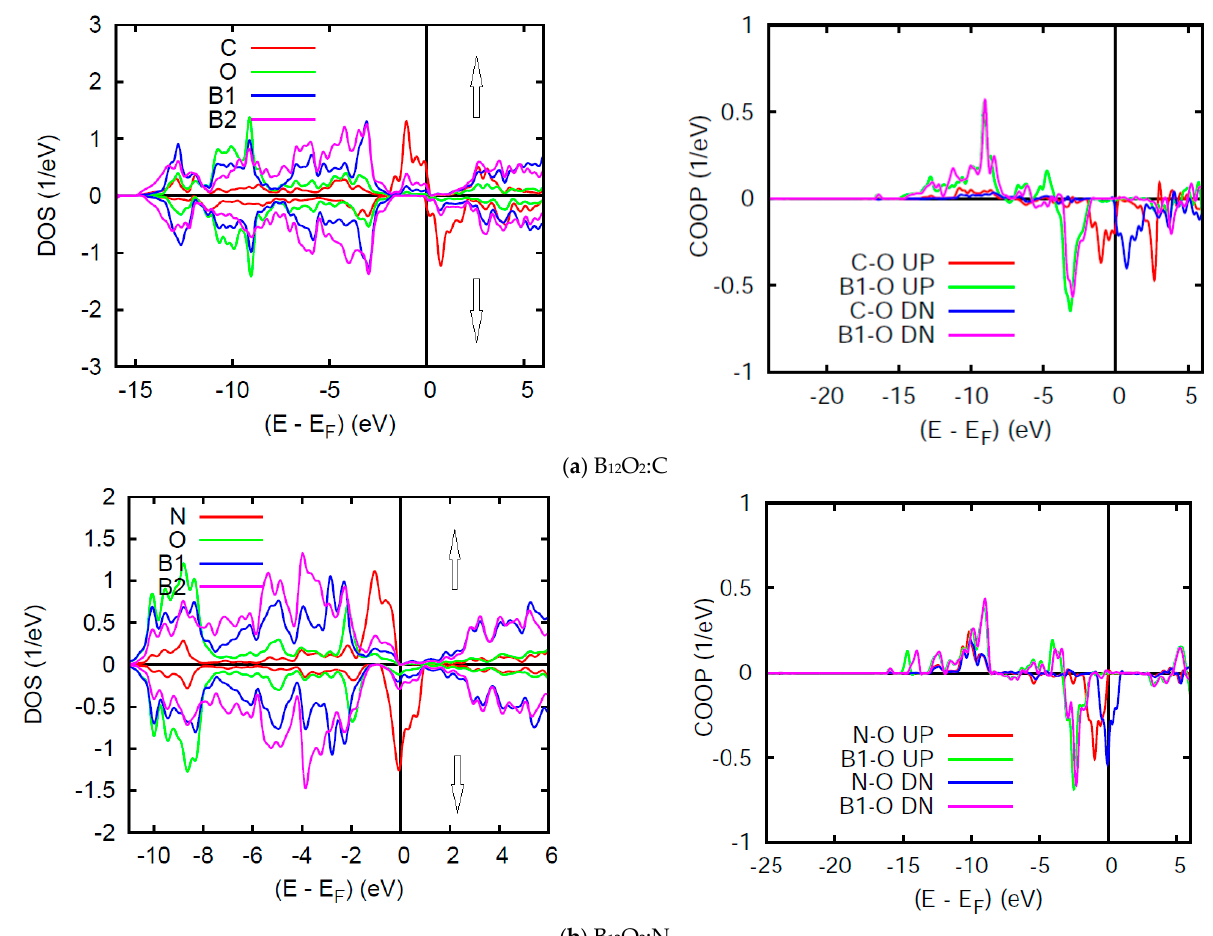
Figure 7. (color) . B 12 O 2 :X. Site and spin projected DOS and COOP in ( a ) X = C, and ( b ) X = N corresponding to 1.9 and 1 μ B , respectively.